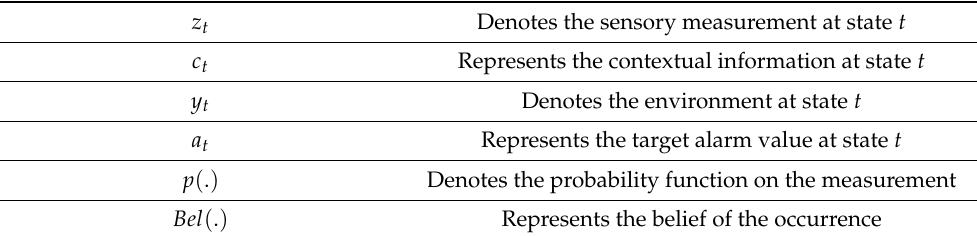
Table 2. The notations used in the CCBI